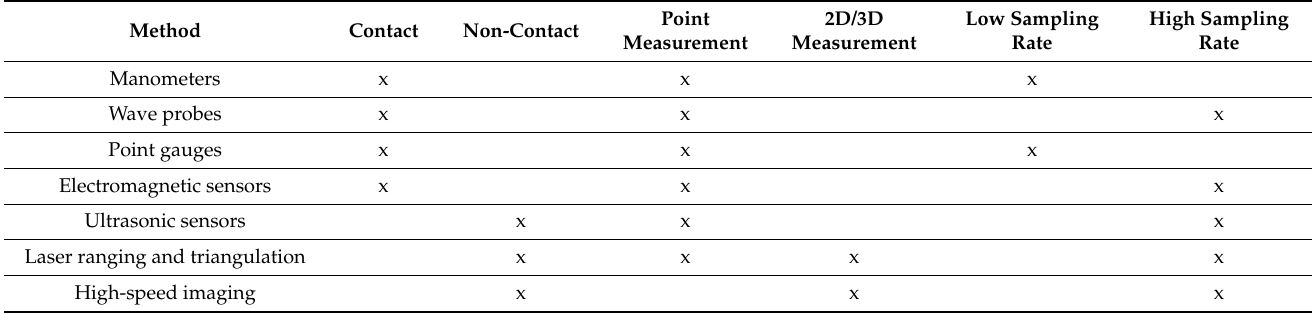
Table 1. General classification of free-water-surface measurement methods. Contact Non-Contact